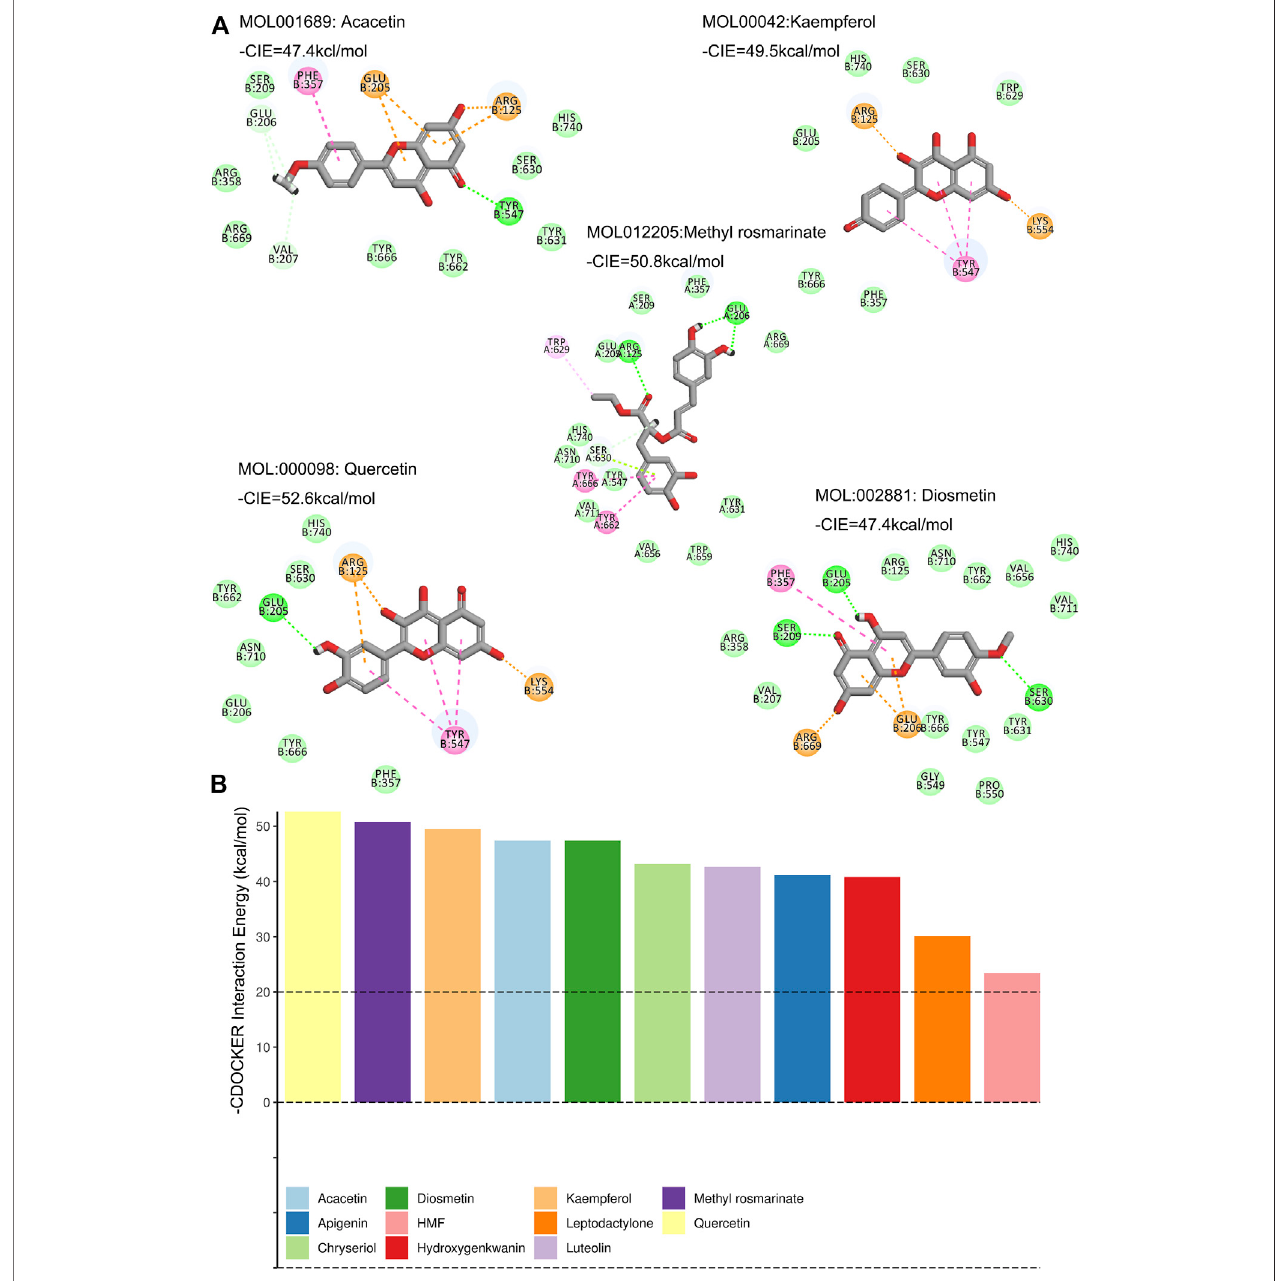
FIGURE 4 | Molecular docking of compounds and DPP4. (A) Molecular docking between the compounds and DPP4 (Show only — CIE top fi ve ranked). Green represents hydrogen bonding, pink represents PI-PI stacked, gold represents salt bridge, green amino acids at the periphery for van der Waals forces. (B) These compounds were ranked according to their -CIE with DPP4. The top fi ve compounds were Quercetin, Methyl rosmarinate, Kaempferol Diosmetin and Acacetin.